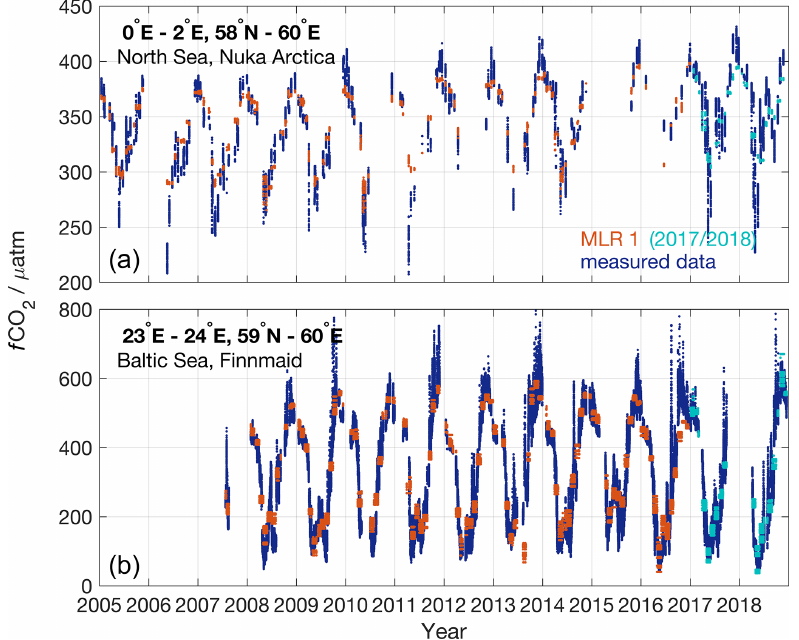
Figure 8. Time series of ship-of-opportunity (SOOP) data from Nuka Arctica ( a , blue) and Finnmaid ( b , blue) compared with MLR 1 at the same location (red). In light blue the predictive MLR output for the years 2017 and 2018 is